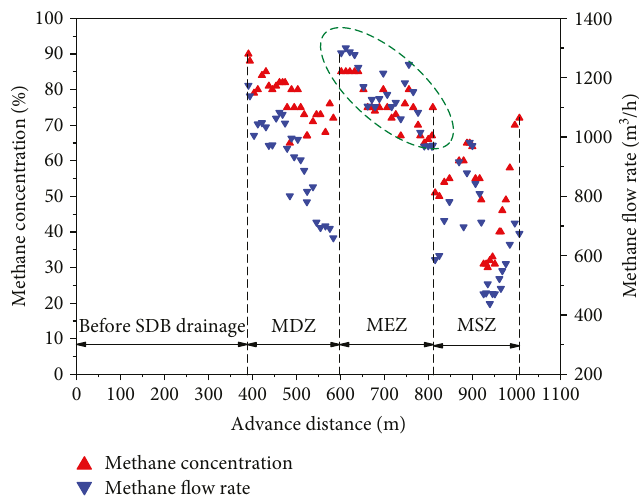
Figure 5: Methane fl ow rate and concentration variations with the increases in the working face advancement